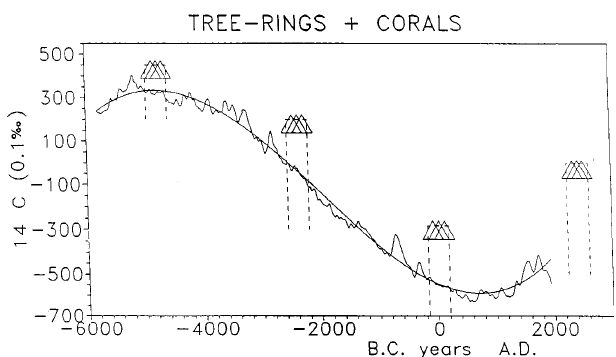
Fig. 6. The data are here plotted for the whole period since 6000 BC . (marine model 14 C ages calculated from the bidecadal atmospheric tree-ring data and a smoothing spline from coral data, Stuiver and Braziunas, 1993). The most stationary parts of the record coincide with the very exceptional segments of solar motion. They are denoted by the dashed vertical lines and by three triangles . The same type of record (approximately stationary, high solar activity) can be expected for the next exceptional segment which will occur between AD 2240